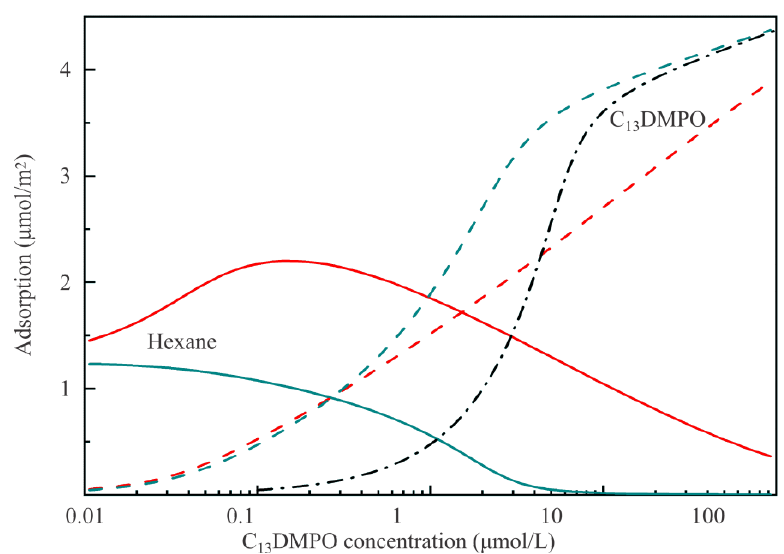
Figure 7. Adsorption values of hexane (solid red line) and C 13 DMPO (dashed red line) corresponding to the theoretical curves 2 and 3 in Figure 6. Green lines show the unrealistic results of calculations made for zero values of k 1 and a 12 . Black dash-dotted line shows the dependence of C 13 DMPO adsorption plotted against the initial concentration c 20 .